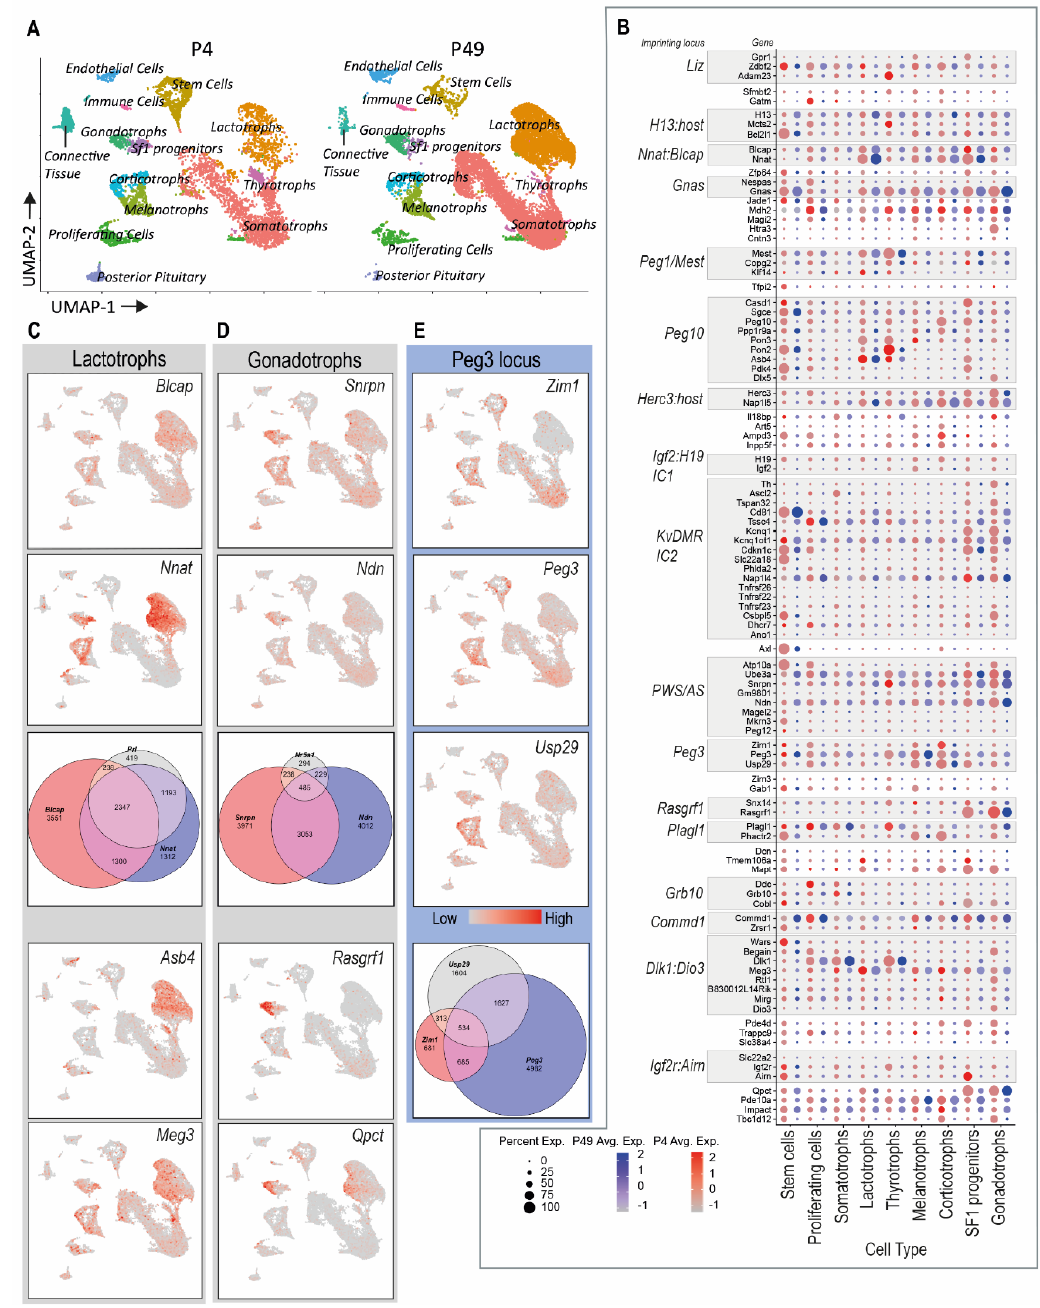
Figure 3. Imprinted gene expression in postnatal day 4 (P4) and postnatal day 49 (P49) anterior pituitary (AP) scRNAseq datasets. Single-cell RNA sequencing of postnatal day 4 (P4) and day 49 (P49) anterior pituitaries revealed 13 distinct cell types shared across the two ages ( A ). Then, 100 known imprinted genes (IGs) expressed in both ages were plotted in all identified cell types ( B ). IGs were grouped according to known IG cluster and relabelled if >1 member of the cluster was present in the dataset. Expression of IGs in P49 cells is shown in blue and P4 in red, whilst the size of the dot is indicative of the IG percentage expression in the specific cell type. Expression of the IGs significantly enriched in the lactotroph lineage ( C ). Linked bladder cancer-associated protein (Blcap) and Nnat showed overlapping expression in the prolactin (PRL)-expressing cells (Venn diagram). Enriched IGs in gonadotrophs. Prader–Willi syndrome (PWS) cluster genes small nuclear riboprotein polypeptide n ( Snrpn ) and necdin ( Ndn ) showed some overlap in cells expressing Nr5a1 (gonadotrophs and steroidogenic factor 1 (SF1) progenitors, Supplementary Figure S4) ( D ). Paternally expressed gene 3 ( Peg3 ) and neigh- bouring genes zinc finger imprinted 1 ( Zim1 ) and ubiquitin-specific peptidase 29 ( Usp29 ) appeared to have overlapping expression, but at the cellular level this was limited ( E ). All three genes were significantly enriched in stem cells (Table 2). Venn diagrams show the circle size proportional to number of cells that express a target gene, and the number of cells is shown in the relevant circle. Grey to red indicates no expression to high expression.